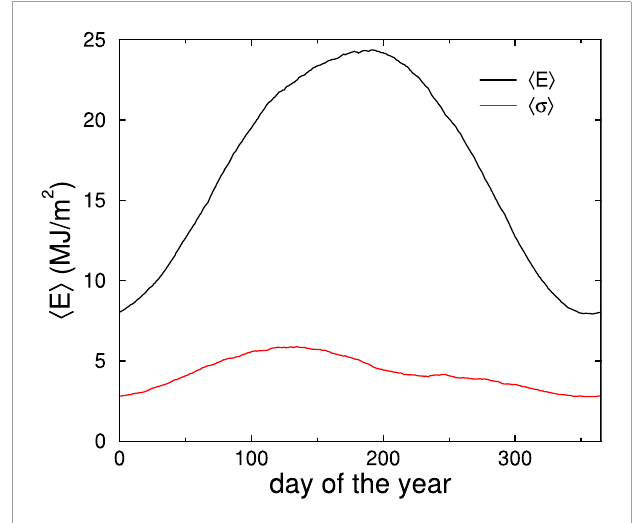
FIGURE 1 Average daily energy ⟨ E ⟩ per unit area from 1980 to 2019 on the St. Louis region (black), and the daily standard deviation ⟨ σ ⟩ in this quantity over the same period (red). These data are smoothed by averaging over 45 consecutive